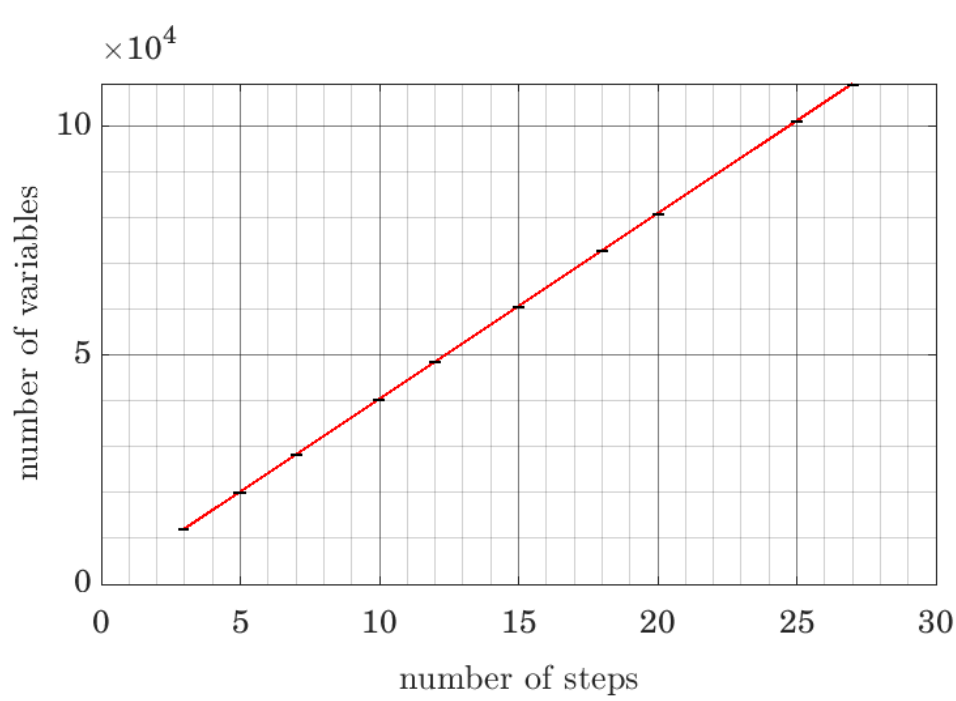
Figure 6. Number of optimization variables after simplification as a function of the number of steps.